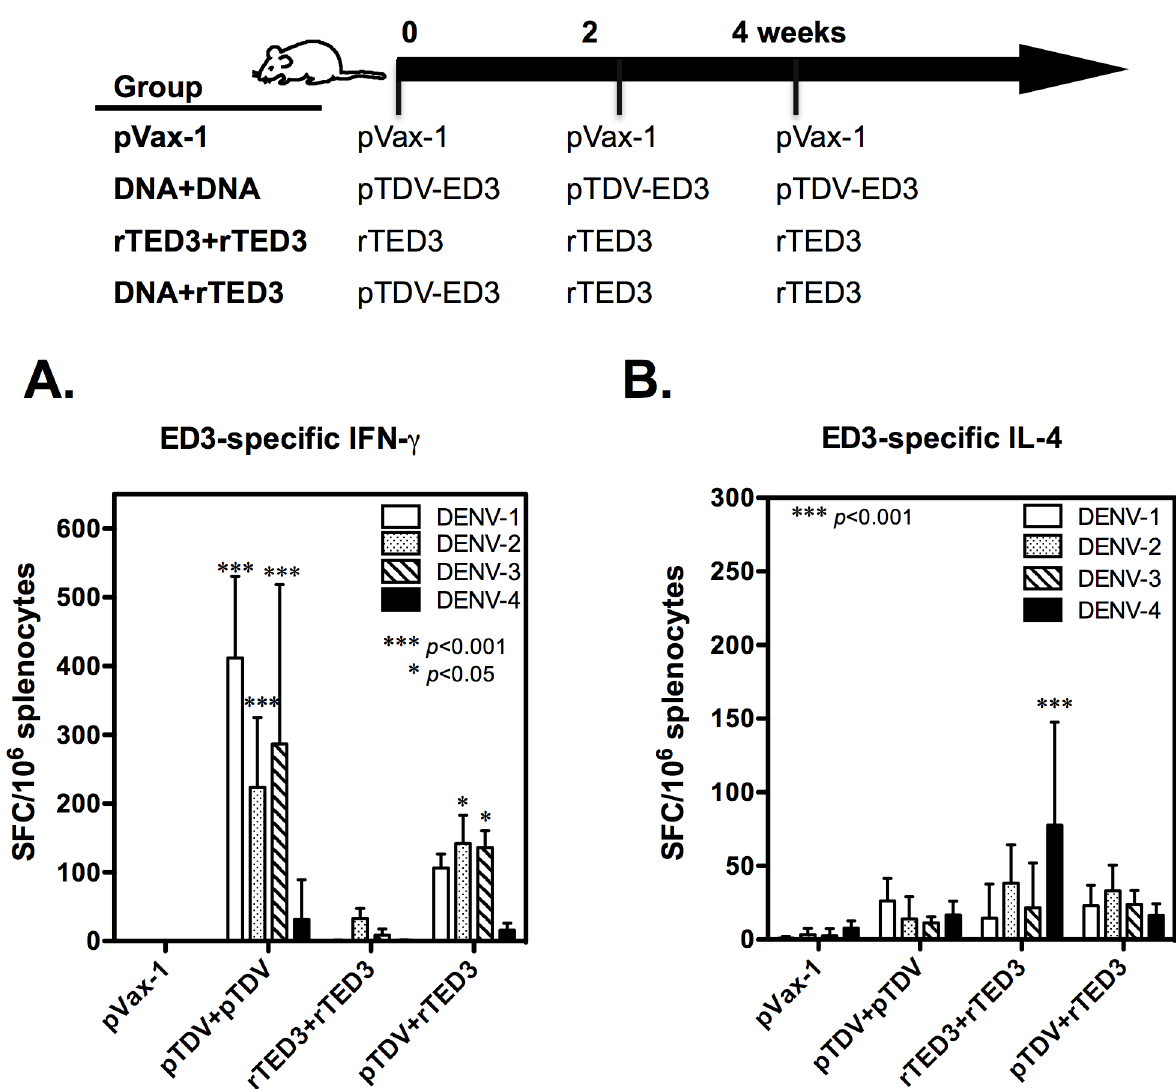
Fig 2. ED3-specific T-cell responses elicited by tetravalent dengue vaccines. Groups of 6- to 8-week-old BALB/c female mice (n = 4) were immunized three times at 2-week intervals with pVax-1, pTDV-ED3 DNA vaccine (pTDV+pTDV), rTED3 protein vaccine (rTED3+rTED3) or prime-boost (pTDV+rTED3) as indicated in the top of figure. One week after last immunization, spleen cells were harvested for the detection of IFN- γ (A) or IL-4 (B) production specific to the ED3 of each serotype by ELISPOT assay. The results are presented with the mean and standard deviation (SD) of spot-forming cells (SFC) per million splenocytes. The significance shown in the graph was determined in comparison to the pVax-1 group, if there is no other indication. The typical results from one out of two independent experiments are